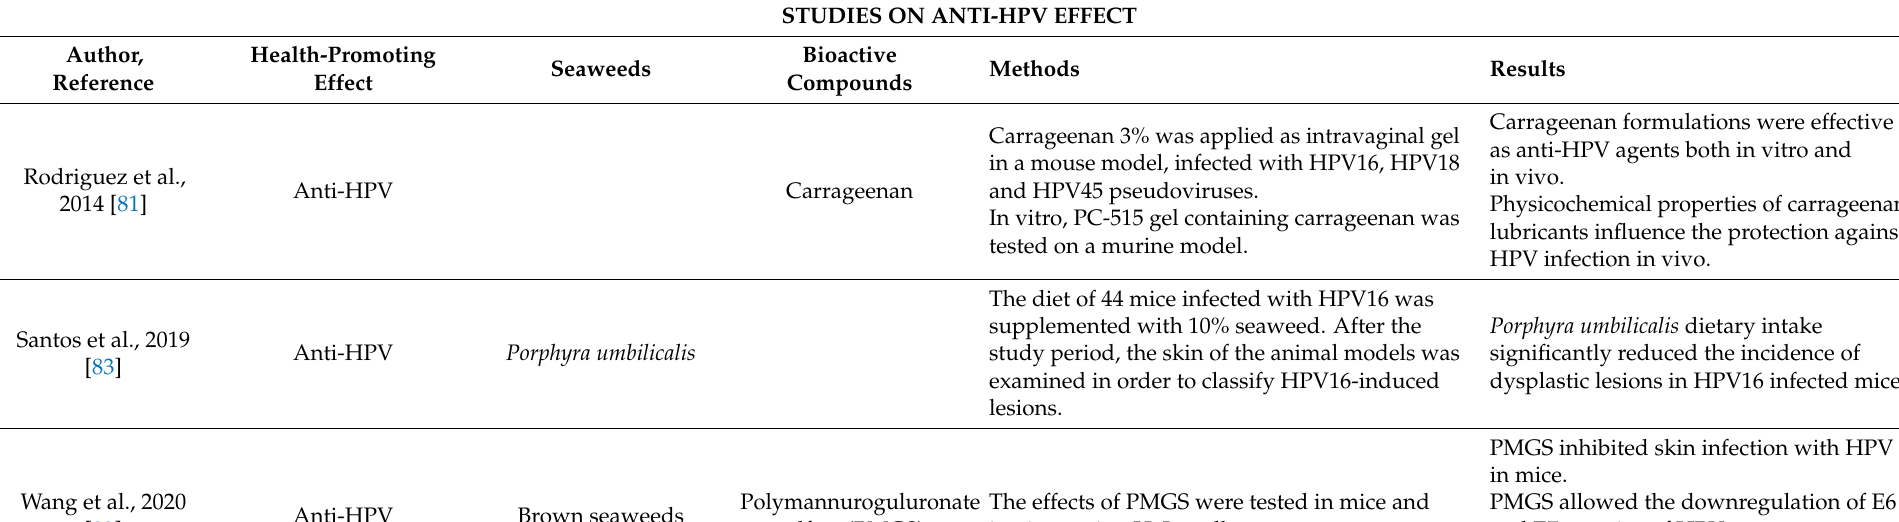
Table 2. Studies of anti-HPV and anti-cervical cancer effects of seaweeds